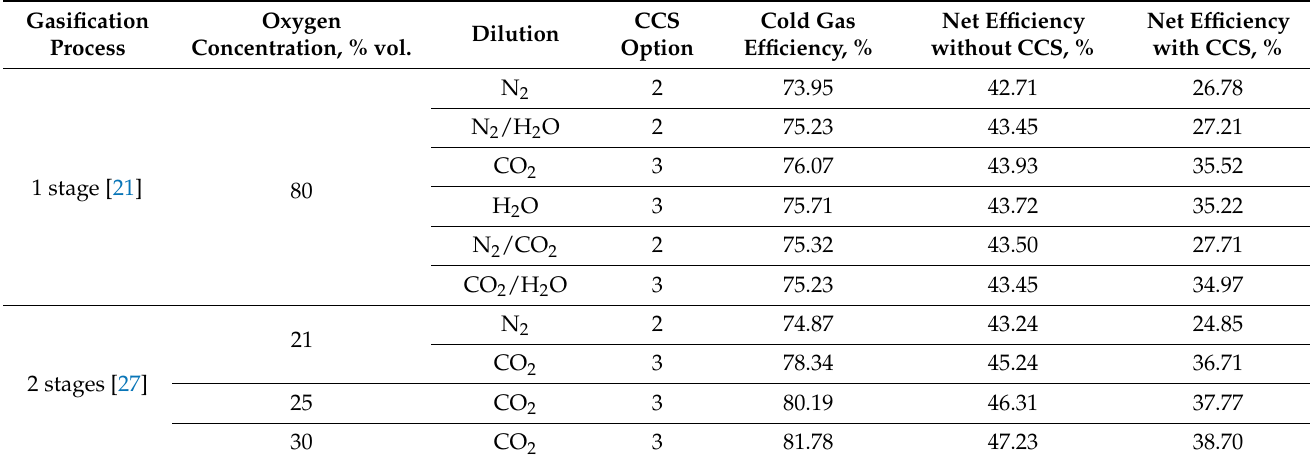
Table 3. Dependence of efficiency on the chosen scheme of a coal-fired IGCC plant and gasifi- cation processes.